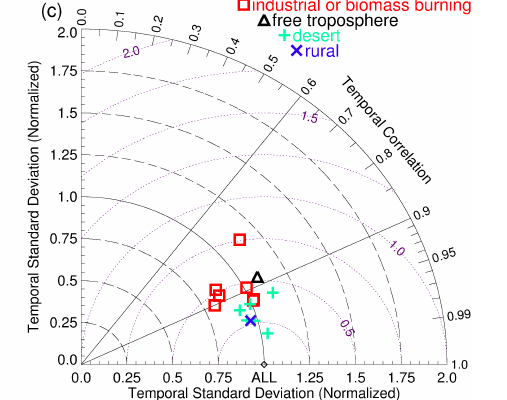
Figure 3. Taylor diagrams for analyzing temporal pattern correlations between monthly means of different/limited sampling ( (a) 10:30 ± 30min, (b) 12:20 ± 30min, and (c) 13:30 ± 30min) and all available sampling using the real-time AERONET AOT (550nm) data. The normalized centered root-mean-square (rms) difference is proportional to the distance from the point “ALL” on the x axis (i.e., shown as purple dashed semicircles). The AERONET stations are classified by regional dominant aerosol types – industrial/biomass burning, free tropospheric, desert, and rural aerosols (Yoon et al., 2012) – and listed in Table 2.